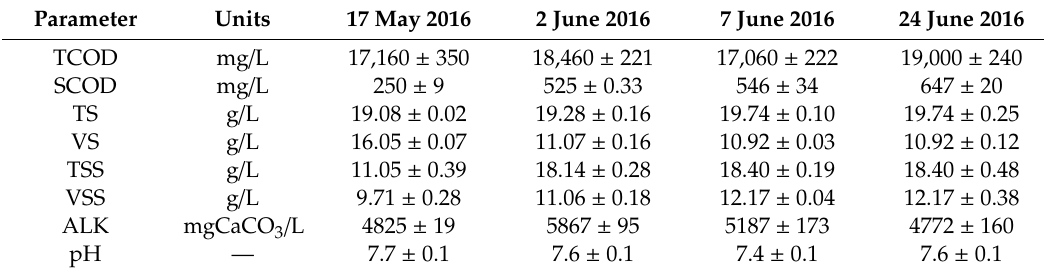
Table 3. Inoculum characteristics.